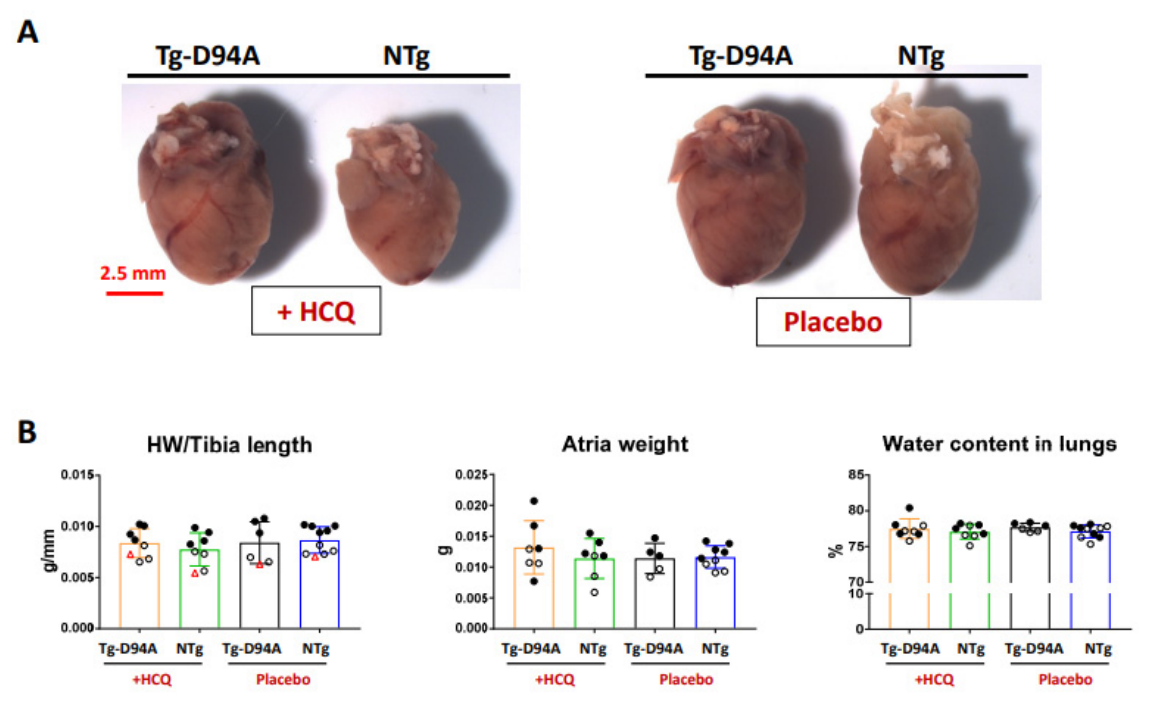
Figure 4. The effect of HCQ vs. placebo (H 2 O) treatment on gross morphology of Tg-D94A vs. NTg animals. ( A ) The hearts of 6-mo-old female Tg-D94A vs. NTg mice treated with HCQ vs. placebo (drinking water). ( B ) The heart weight/tibia length, atria weight, and the water content in the lungs of HCQ vs. placebo-treated Tg-D94A and NTg littermates. Hearts depicted with red triangles in the HW/tibia length graph represent the hearts pictured in Figure 4A. Open symbols show female and closed-male mice. Data are presented as the mean ± SD. No statistical significance was found by two-way ANOVA followed by Sidak’s multiple comparison test.